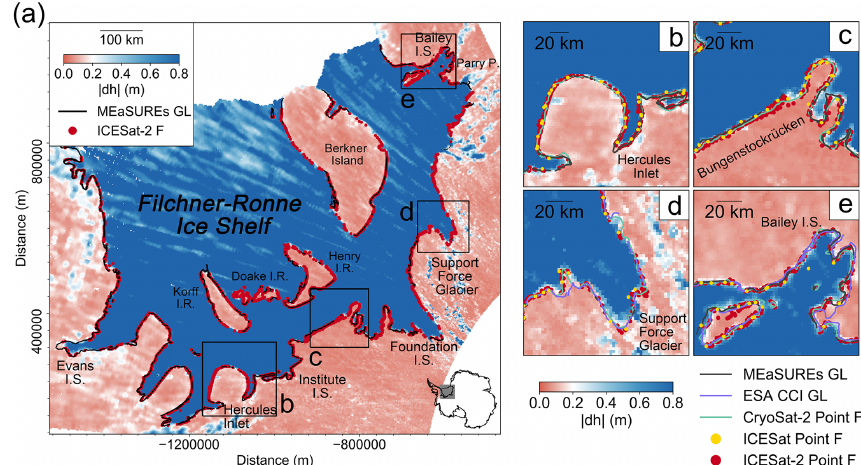
Figure 6. (a) Spatial distribution of the absolute elevation change at ICESat-2 crossovers per 2km grid cell across the Filchner–Ronne Ice Shelf; the four black boxes denote the individual regions plotted in (b) – (e) . (b) Hercules Inlet, (c) Bungenstockrücken, (d) Support Force Glacier, (e) Bailey Ice Stream. In subplots (b) – (e) , the ICESat-2-derived inland limits of tidal flexure (Point F) are shown as red dots. The ICESat-derived Point F locations are shown as the yellow dots. The MEaSUREs DInSAR-derived Point F (Rignot et al., 2016) is shown as the black line. The ESA CCI DInSAR-derived Point F is shown as the purple line. The CryoSat-2-derived Point F is shown as the green line (Dawson and Bamber, 2020).